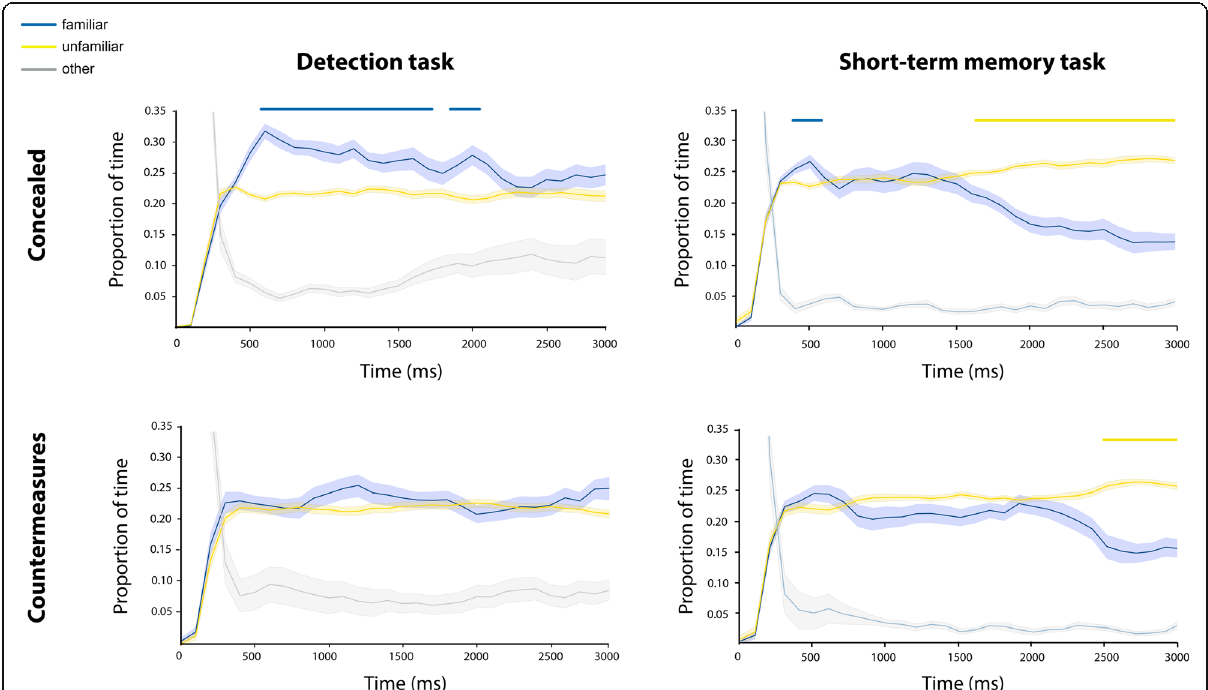
Fig. 2 Time course of gaze position in the current study (left panel) and in the previous one (right panel). The concealed experiments are displayed on top and the countermeasures at the bottom. The graph depicts the proportion of fixation time directed at familiar (blue) and unfamiliar (yellow) faces (averaged across the 3 unfamiliar faces) during the parallel display. Eye movements outside the interest areas or blinks are presented in gray. Time points with a significant difference (after False Discovery Rate (FDR) correction) between familiar and unfamiliar faces are displayed at the top of the figure as blue or yellow bars for familiarity preference and avoidance effects, respectively. Shadowed area indicates ±1 standard error (SE) across